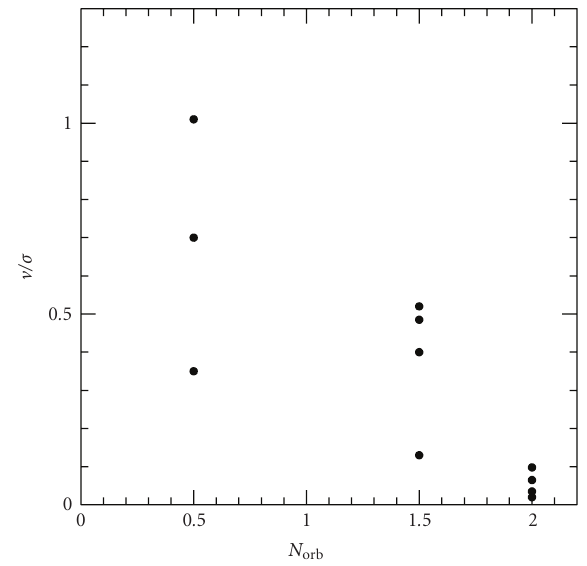
Figure 5: v/σ as a function of the number of orbits for the satellites in the cosmological hydrodynamical simulation of Governato, Mayer et al. [56]. v/σ is measured within the half mass radius of the dwarfs at the end of the simulation, namely, after 13 billion years of evolution. The mean number of orbits for each of the three groups of dwarfs appears on the horizontal